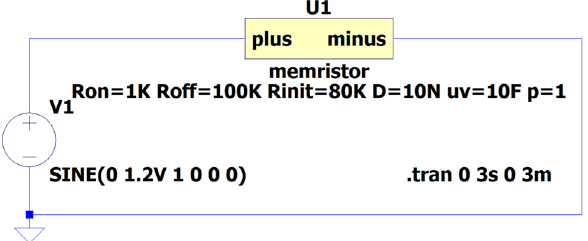
Fig. 2 Memristor component